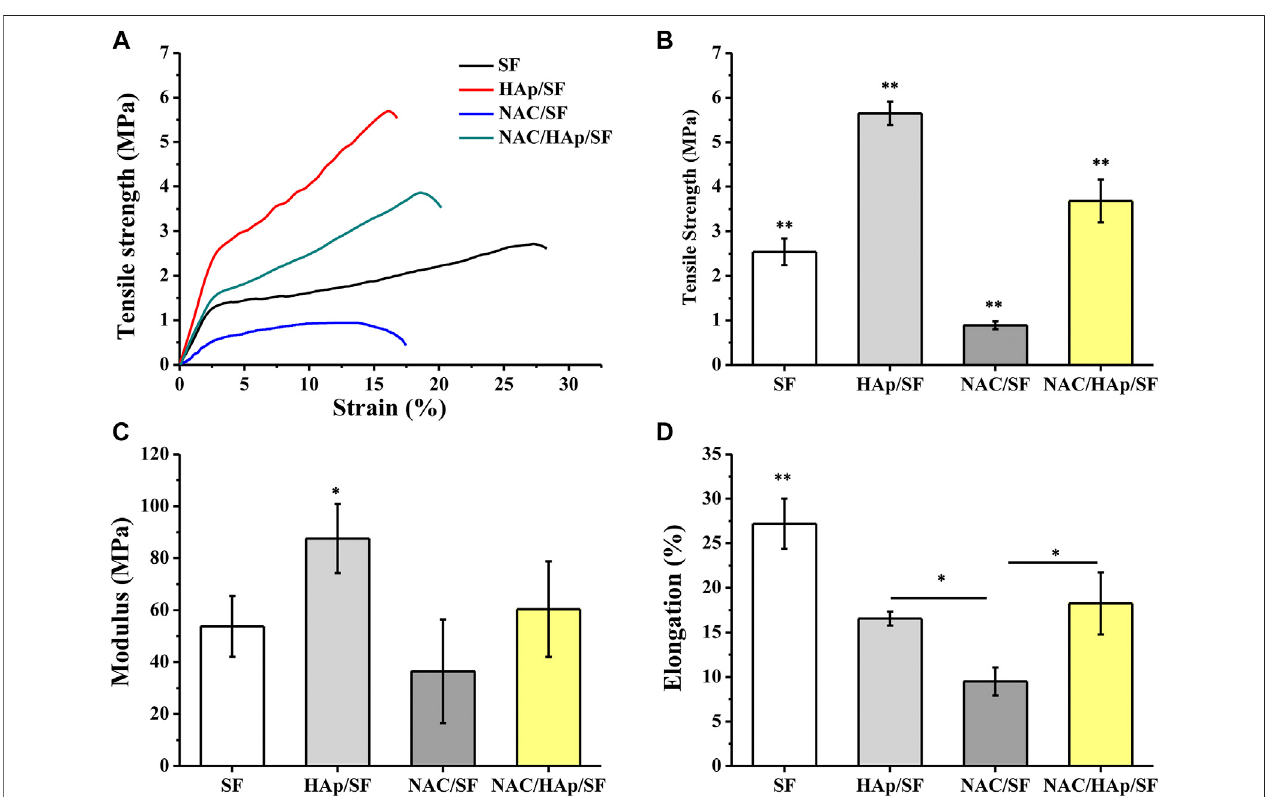
FIGURE 2 | Analysis of tensile properties of the composite fi brous scaffolds including typical stress-strain curves (A) , tensile strength (B) , modulus (C) and elongation (D) . * p < 0.05, ** p < 0.01, n (cid:1) 5.